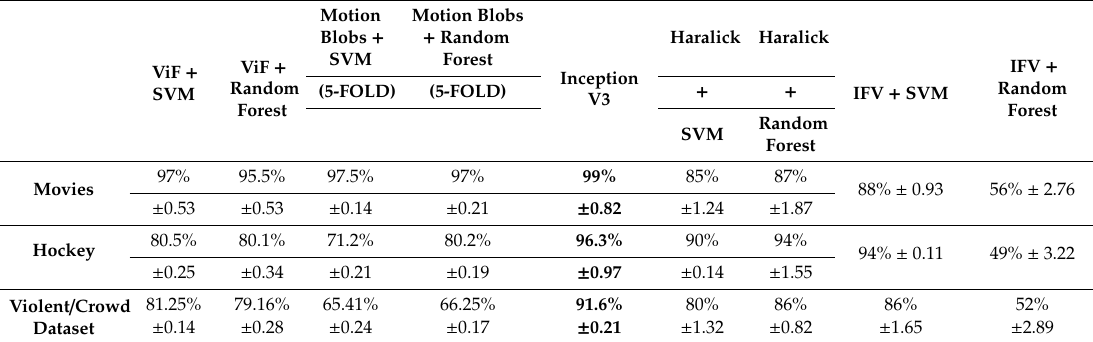
Table 4. Controlled benchmark